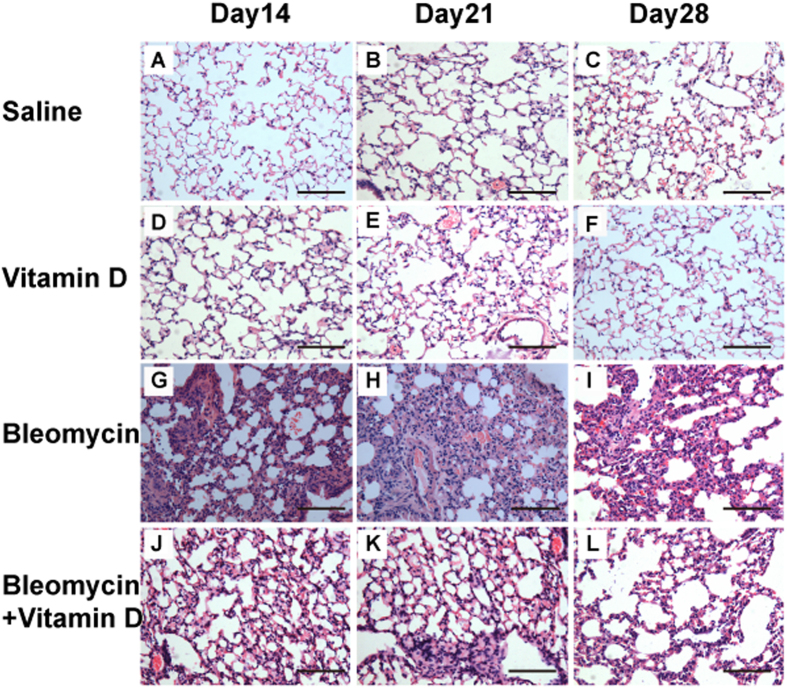
Histological examination showed that vitamin D treatment reduced pulmonary fibrosis induced by bleomycin.The alveoli in the saline group were normal on days 14 (A), 21 (B) and 28 (C). In the bleomycin group, the alveolar septa were thickened, with a significant quantity of inflammatory and interstitial cells present in the pulmonary interstitium on day 14 (D); on day 21, fewer inflammatory cells and more interstitial cells were identified in the lung interstitium (E). The extent of alveolitis was remarkably reduced, with mainly fibroblast proliferation and collagen deposition, whereas the lung histological architecture was disordered on day 28 (F). In the bleomycin+vitamin D group, the extent of alveolitis and pulmonary fibrosis was significantly less than that in the bleomycin group on days 14 (G), 21 (H) and 28 (I). In the vitamin D group, the alveoli were normal on days14 (J), 21 (K) and 28 (L). Bars = 100 μm